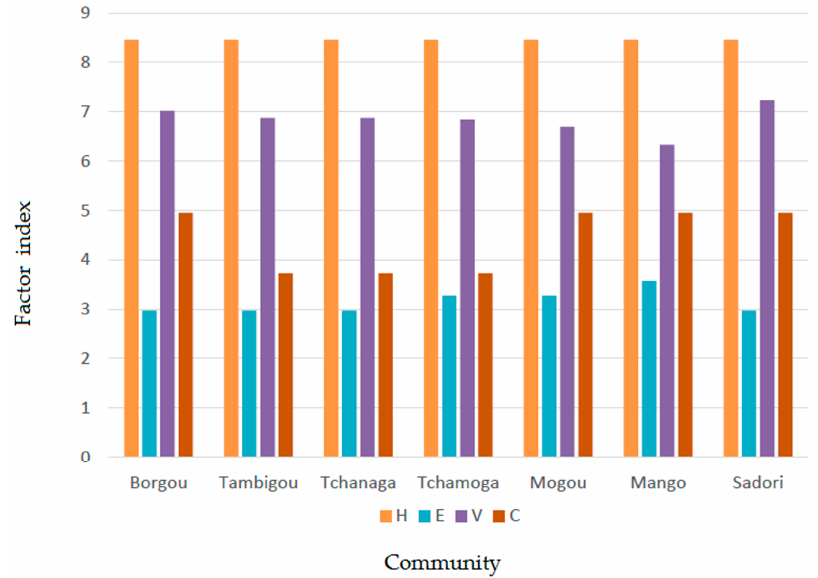
Figure 3. Computed indices of the four risk factors for the different communities. C, H, V and E stand for capacities, hazard, vulnerability and exposure indices.